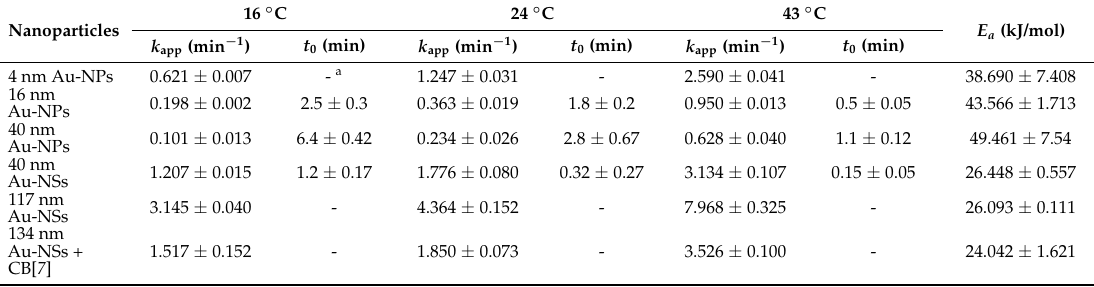
Table 1. Summary of the apparent rate constant ( k app ), induction time ( t 0 ) at three different temperatures, and the apparent activation energies ( E a ) for gold nanoparticles in this work. Nanoparticles